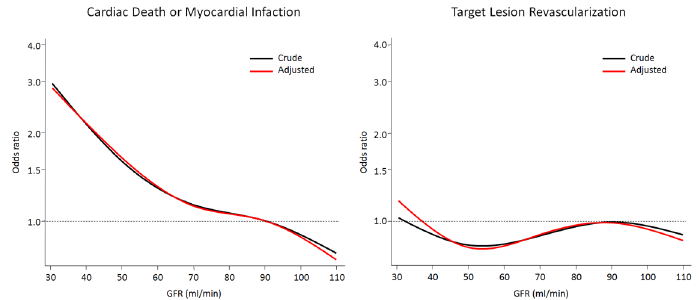
Figure 1. Predicted Risk of Adverse Clinical Outcomes According to Renal Function. Crude and adjusted predicted 2-year odds ratios for the composite of cardiac death and myocardial infarction (left) and target-lesion revascularization (right) at different levels of baseline glomerular filtration rate (GFR), using 90 ml/min as reference.